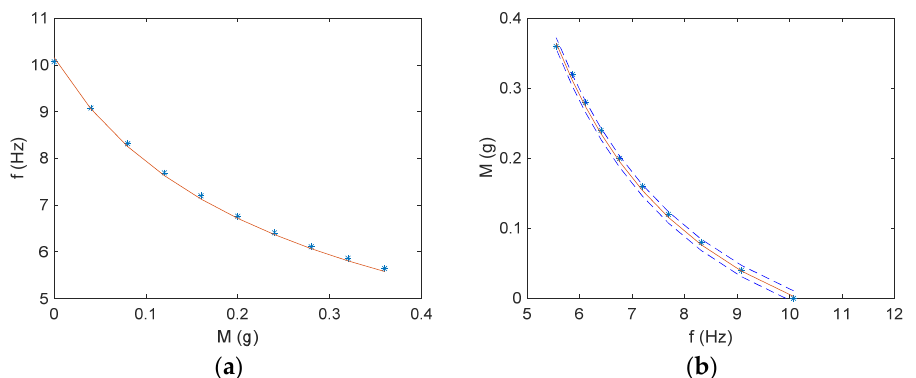
Figure 8. ( a ) Sensor response in the case of the following operating conditions: B = 0.0948 T and I d = 20 mA. Model (10) has been used to fit experimental data. ( b ) Calibration Diagrams for the same operating conditions, obtained by inverting model (10). A coverage factor of 2 has been used for the uncertainty bandwidth.